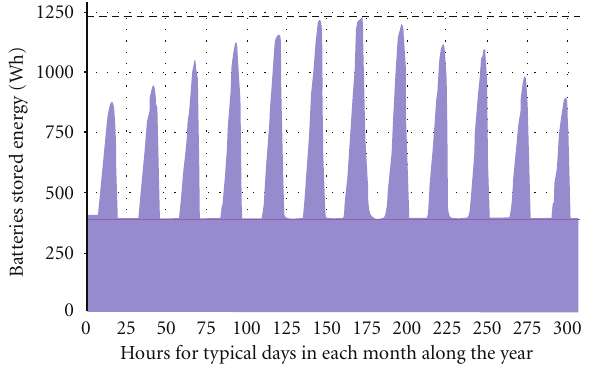
Figure 14: Stored energy along a